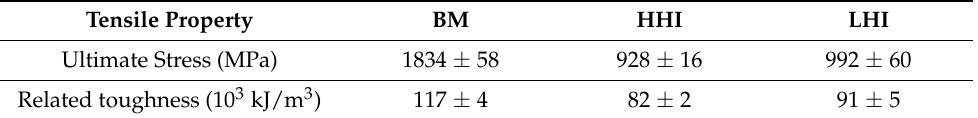
Table 4. Tensile strength and relates toughness of BM, HHI, and LHI welded condition for the Q&T HHA steel